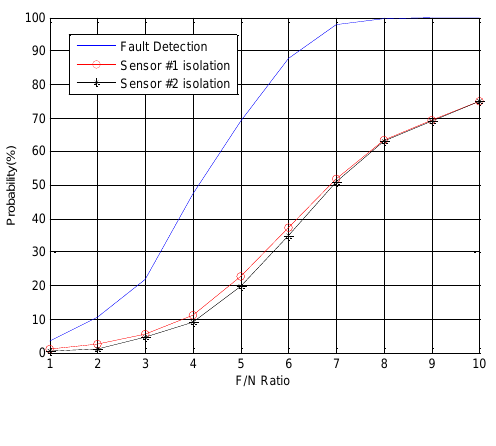
Figure 5. FDI probability of double faults: sensor 1 and sensor